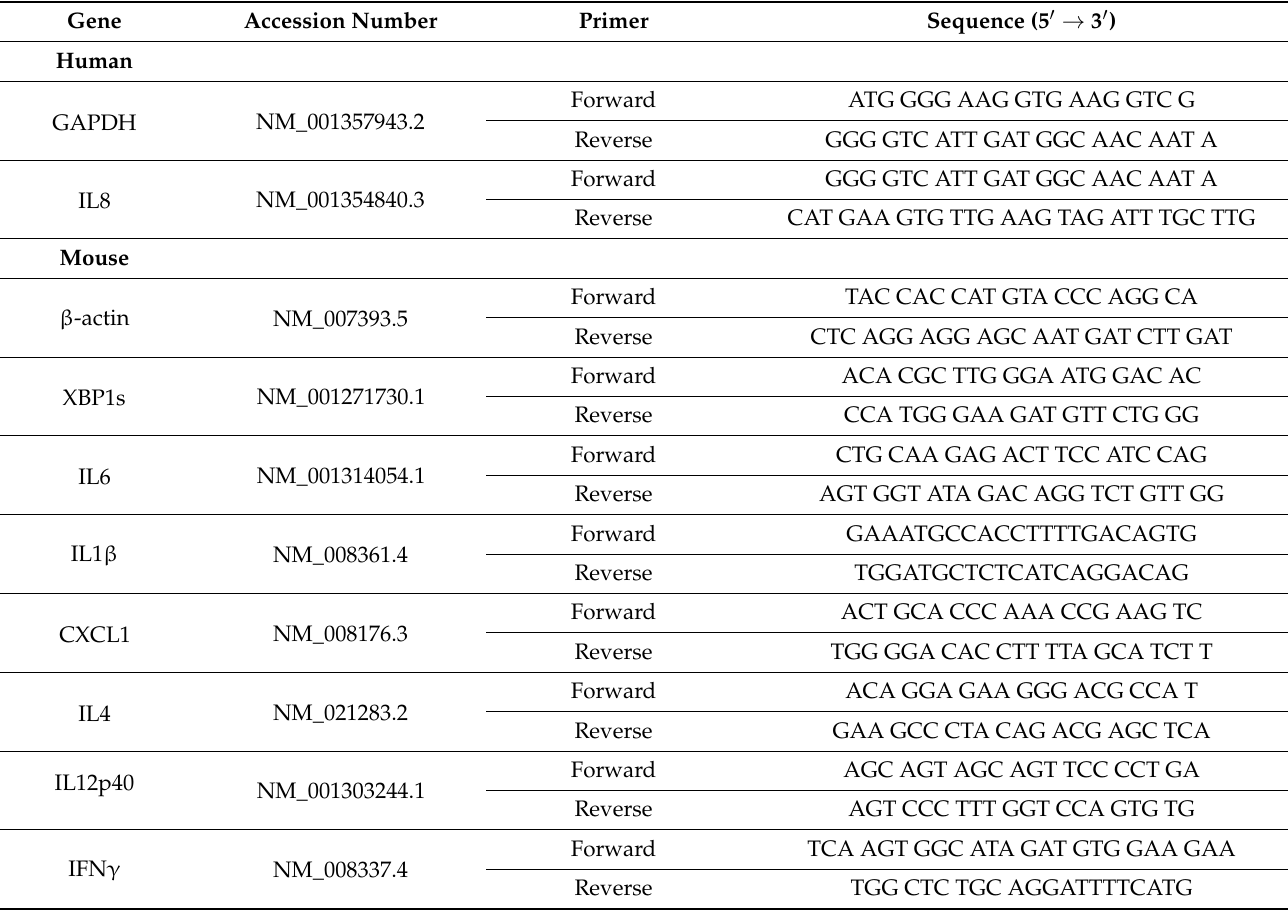
Table 1. Real-Time qPCR primer